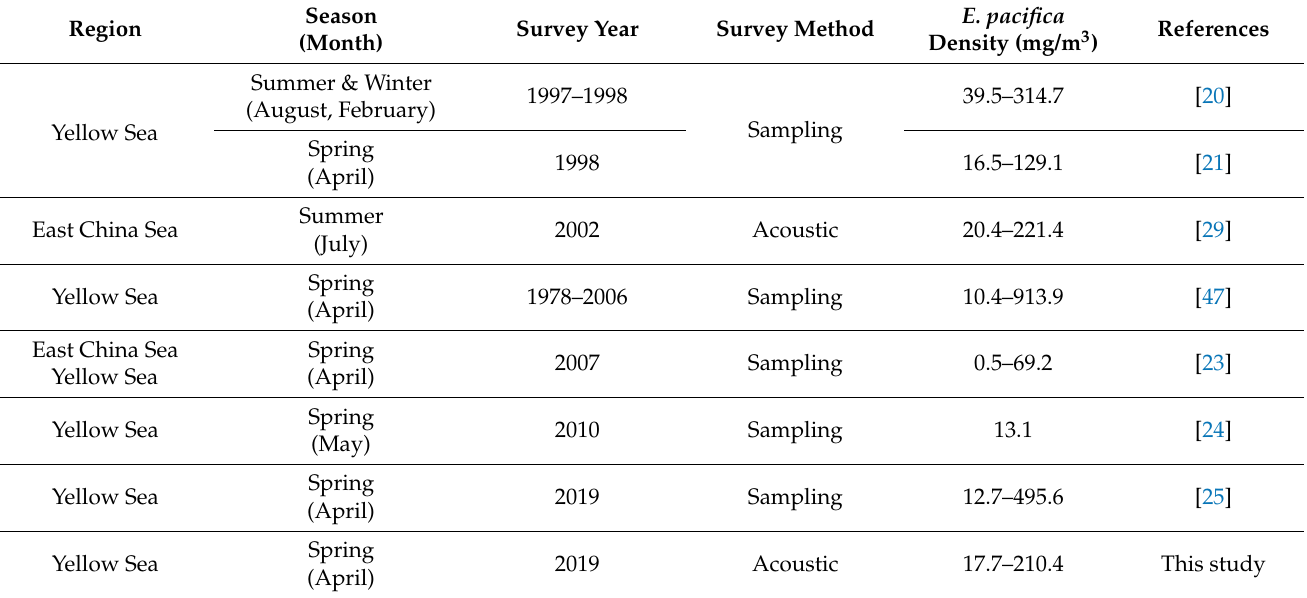
Table 3. Comparison of E. pacifica density results between previous studies and the present